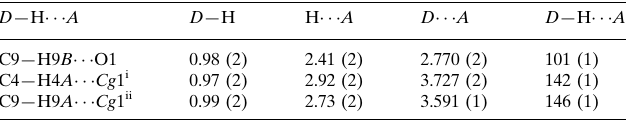
Hydrogen-bond geometry (A˚ , (cid:1)